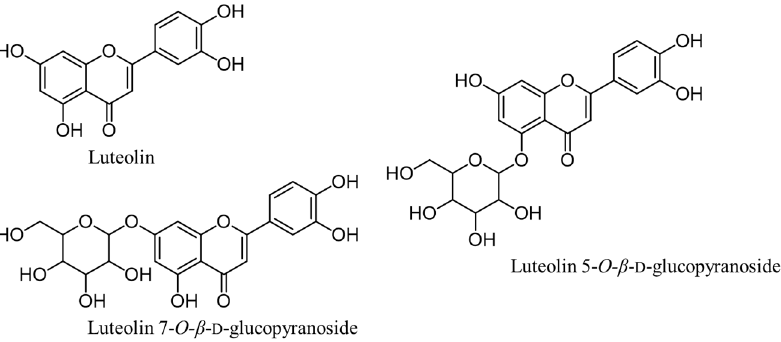
Figure 1. Structures of different isolated compounds from C. maackii .